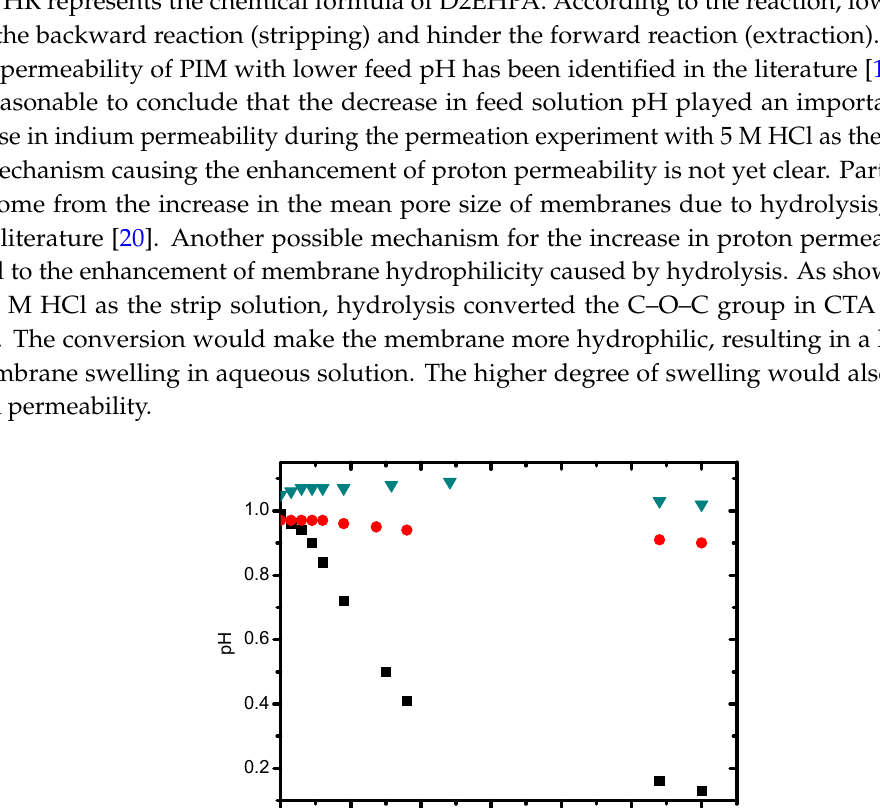
Figure 3. Time dependence of indium concentration in the feed solution for conventional PIM and